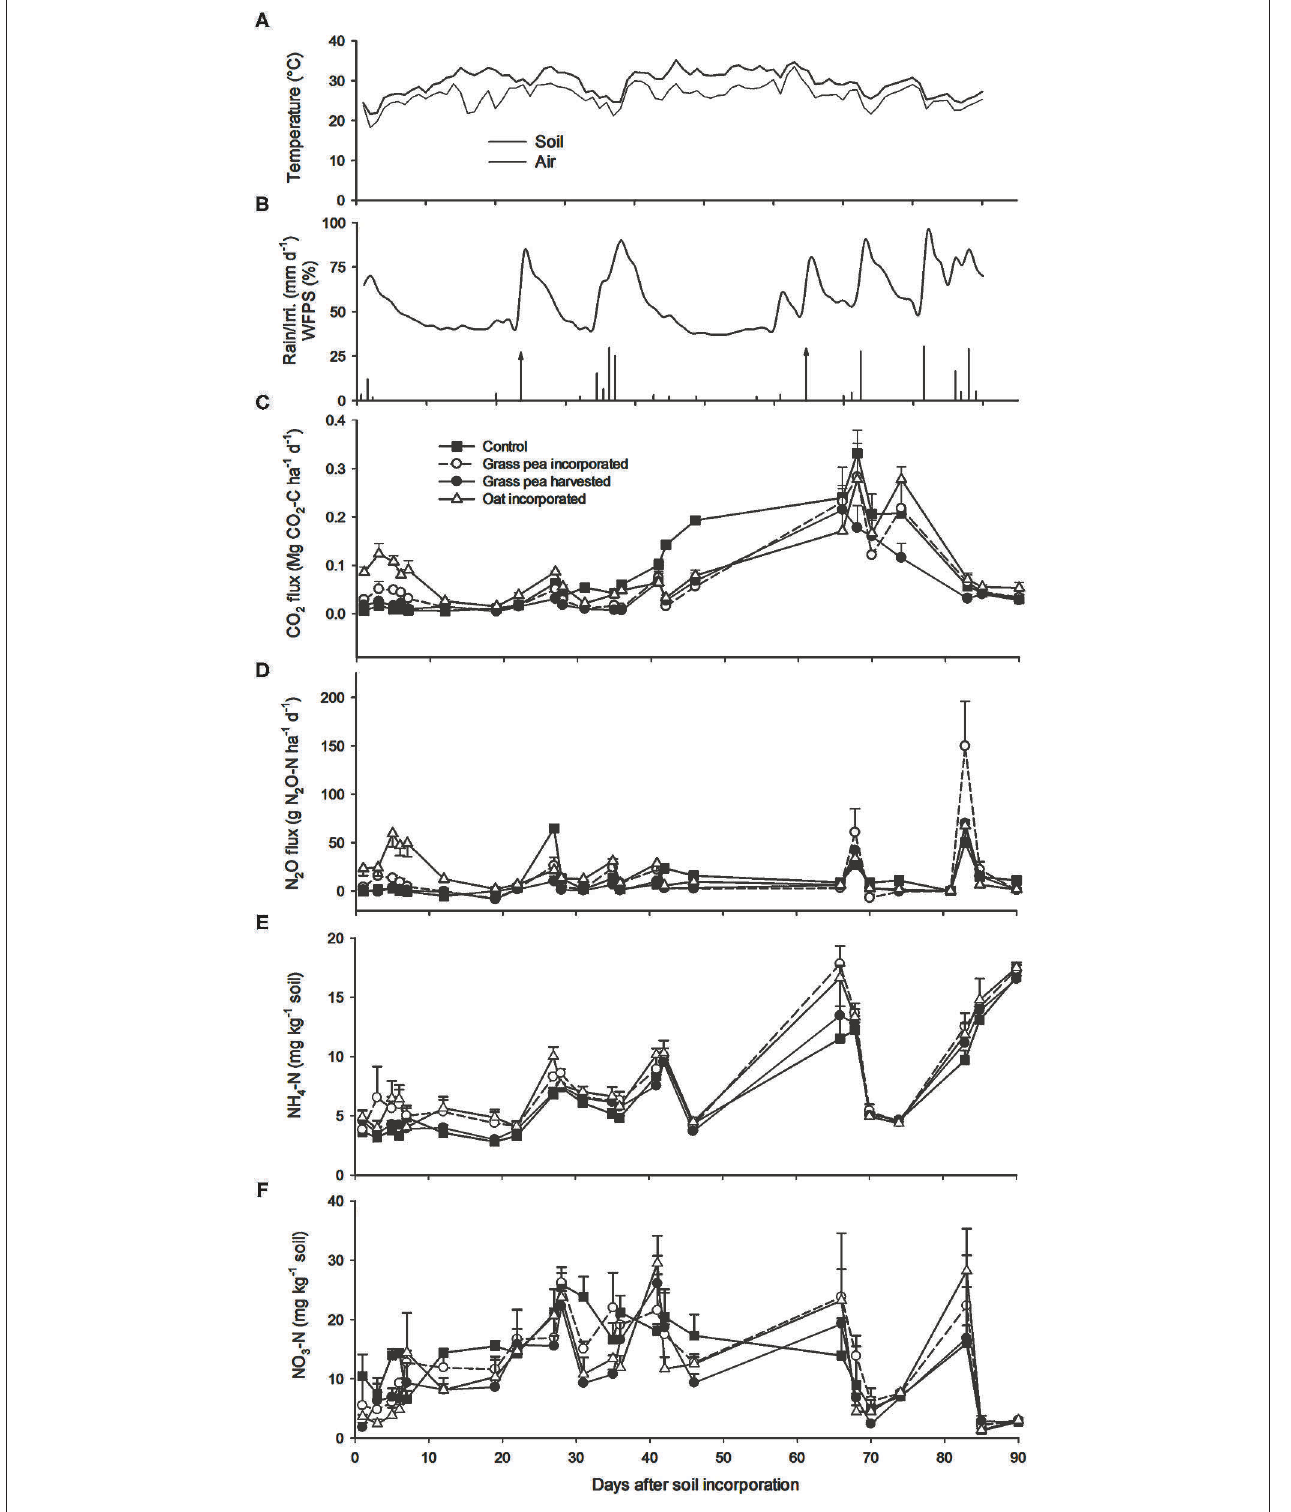
FIGURE 1 | (A) Average soil and air temperatures during flux measurements. (B) Dynamics of daily precipitation (black bars), irrigation amount (gray bars with arrows), and water-filled pore space (WFPS) measured at 0–0.15m soil depth (black line) during flux measurement. Dynamics of (C) carbon dioxide (CO 2 ), (D) nitrous oxide (N 2 O) emissions, (D) ammonium (NH + 4 ), and (E) nitrate (NO − 3 ) N in the 0–0.15m soil depth. Unidirectional error bars are shown for clarity. Error bars (C–F) represent standard error ( n =